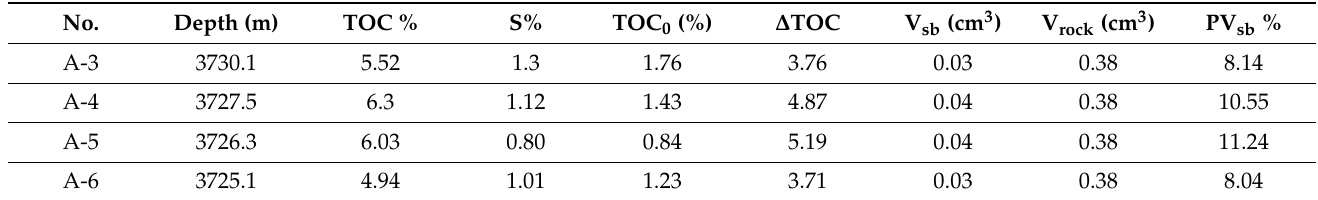
Table 1. The calculation of filled solid bitumen at the bottom of Wufeng